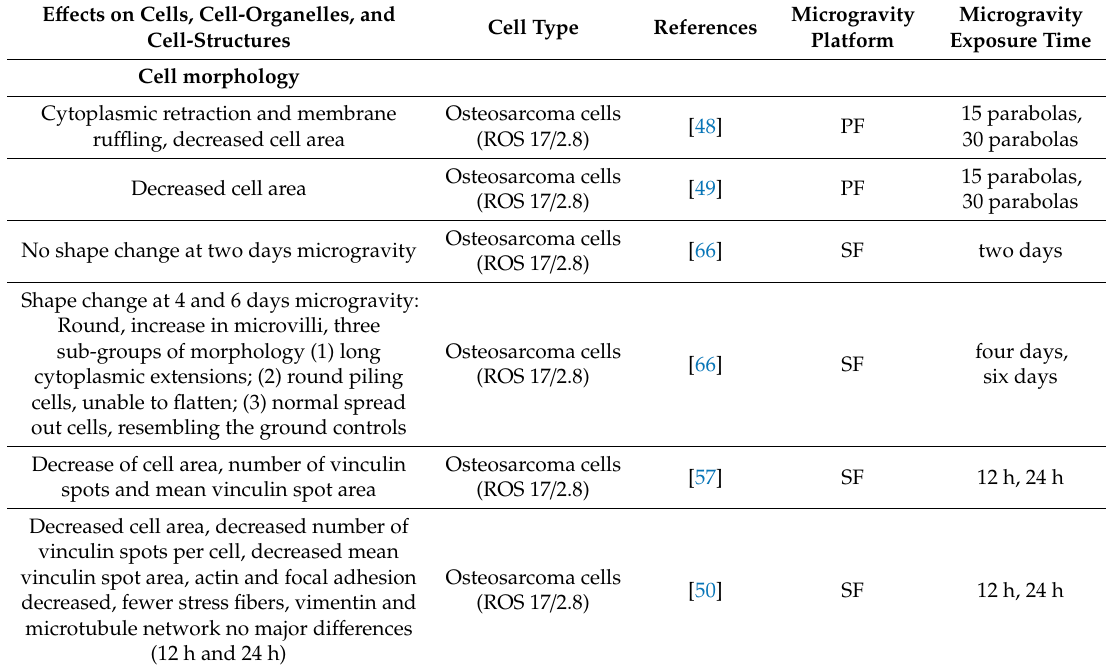
Table 5. Literature overview of the e ff ects of microgravity on cell organelles, structures and morphology observed in mammalian cells or molecules exposed to real microgravity on di ff erent platforms (PF: Parabolic flight, SR: Suborbital rocket, SF: Space flight). E ff ects on Cells, Cell-Organelles, and